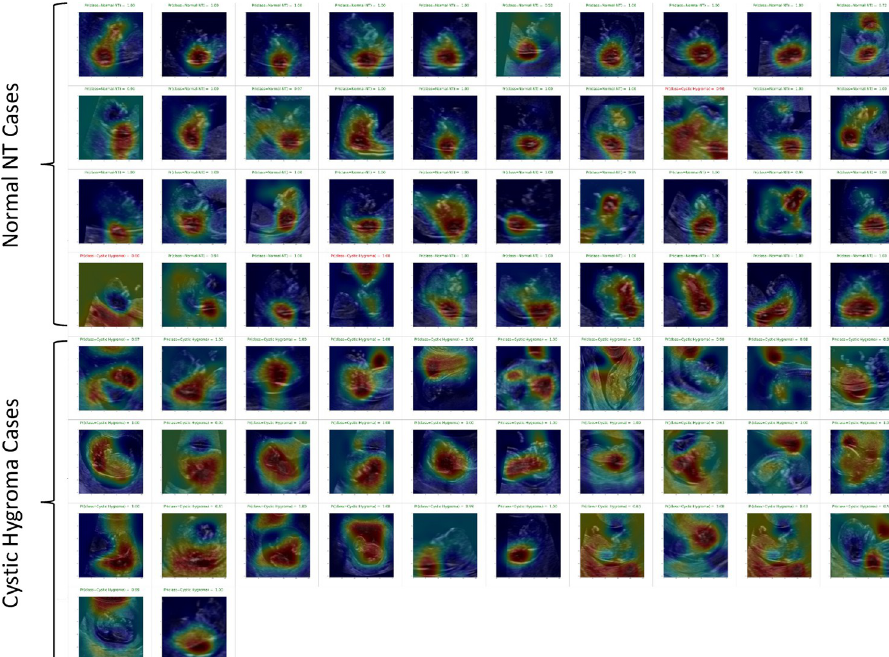
Fig 6. Grad-CAM heat maps for the full validation set of Fold 2. Top 4 rows are normal NT cases and bottom 4 rows are cystic hygroma cases. Red colours highlight regions of high importance and blue colours highlight regions of low or no importance. Therefore, a good model would have Grad-CAM heatmaps that highlight the head and neck area for both normal and cystic hygroma images.